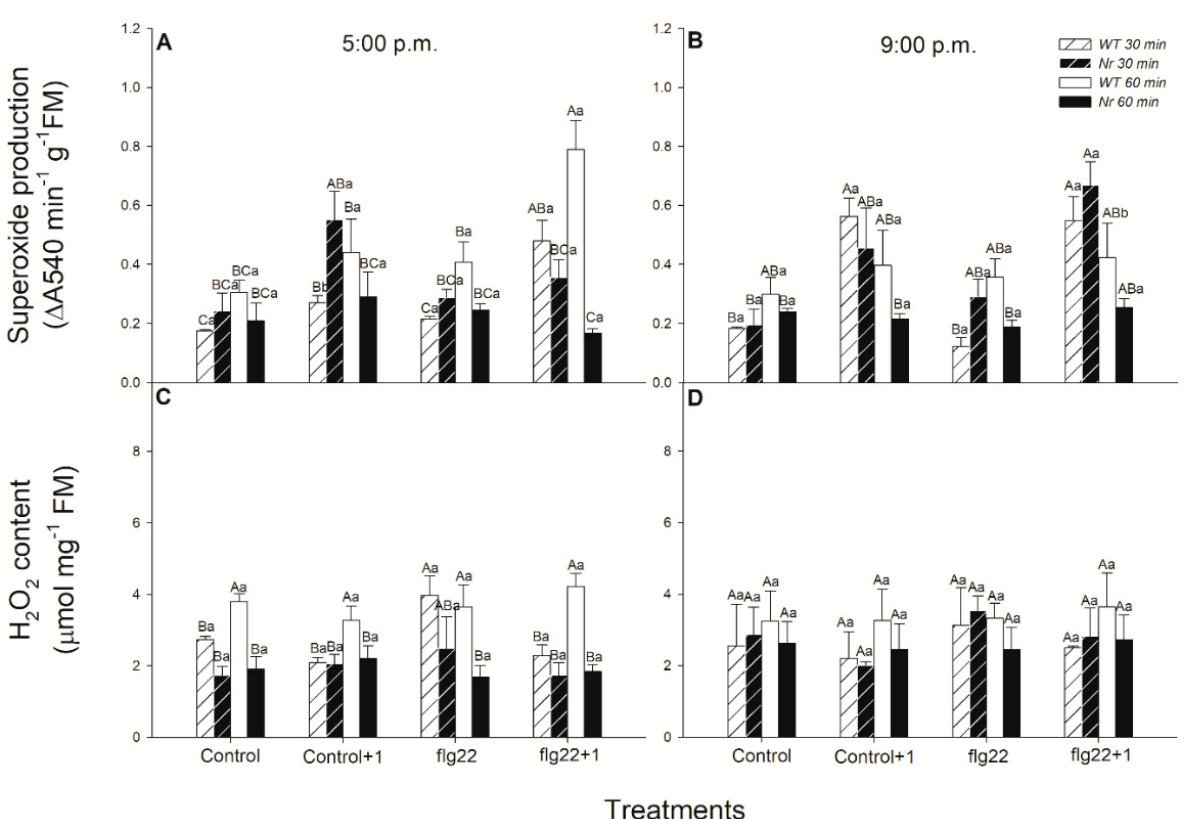
Figure 1. Changes in the superoxide production ( A , B ) and H 2 O 2 content ( C , D ) in leaves of intact wild type (WT; white columns) and ethylene-insensitive Never ripe ( Nr ; black columns) tomato plants treated foliar using a squirrel-hair brush with 5 µ g mL − 1 of flagellin (flg22) in the late afternoon under light (at 5:00 p.m.) or at night under darkness (at 9:00 p.m.). Measurements were carried out 30 min and 60 min after treatments. Whole leaves from different leaf levels and genotypes were ground and superoxide production, as well as H 2 O 2 content, were determined using spectrophotometric methods. Means ± SE, n = 3. Means were analysed by two-way ANOVA; significant differences among the data were analysed by Duncan’s test. Mean values significantly different at p < 0.05 are indicated by different letters, upper case letters indicate the effects of the treatment at the same time of day and lower case letters indicate the effects of daytime under the same treatment. (Control, treatment with sterile distilled water; Control+1, untreated distal leaf level to the control; flg22, treatment with 5 µ g mL − 1 of flagellin dissolved in sterile distilled water; flg22+1, untreated distal leaf level to the flg22-treated